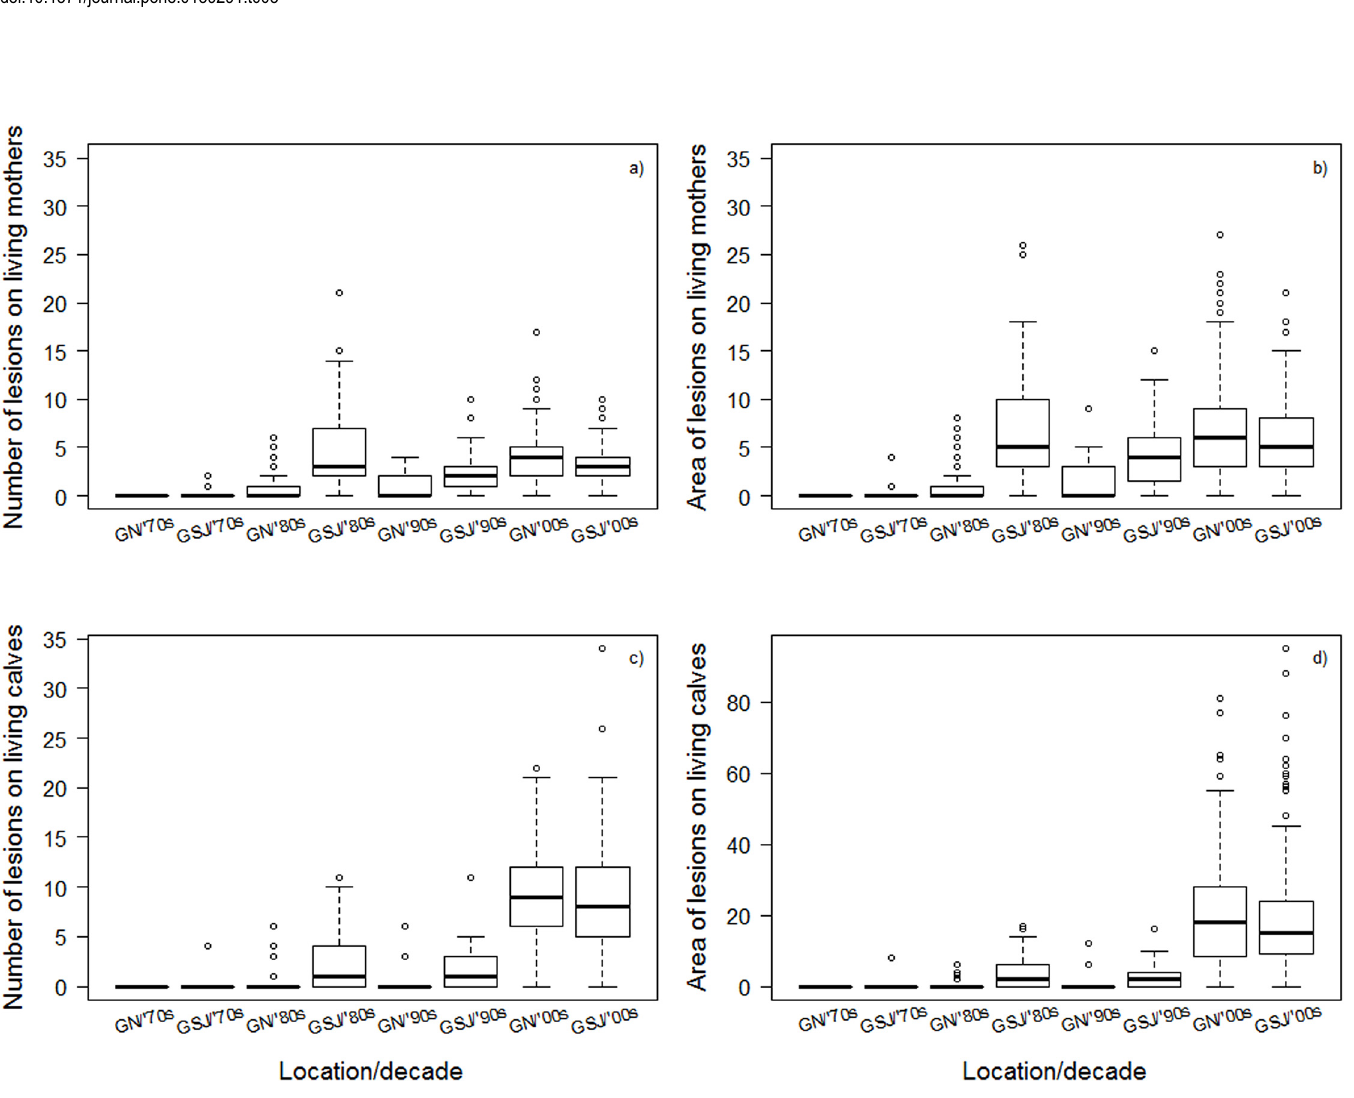
Fig 6. Number of lesions on living mothers (a, b) and calves (c, d) by decade and location (GN: Golfo Nuevo, GSJ: Golfo San José). Median values (thick black line), minimum and maximum (whiskers), first and third quartiles (thin black lines), and outliers (open circles) are shown in the